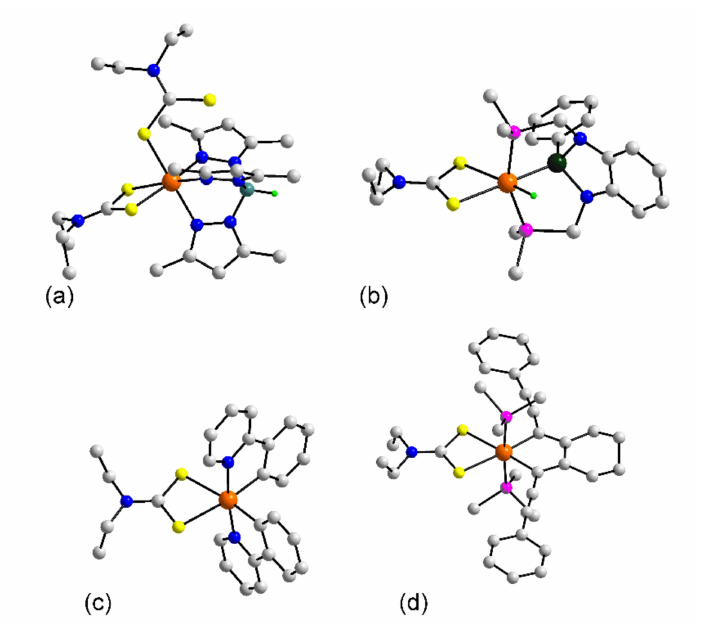
Figure 7. Molecular structures of rhodium complexes: ( a ) Tp*Rh( η 2 - L 24 )( η 1 - L 24 ) ( 73 ), ( b ) [Rh(H){ κ 3 - P,Si,P (cid:48) -SiPh(NCH 2 PPh 2 ) 2 C 6 H 4 }( L 24 )] in the crystal of 74 , ( c ) Rh(phpy) 2 ( L 24 ) ( 75 ), and ( d ) (PMe 3 ) 2 Rh(X 2 ) ( L 24 ) ( 77 ). In ( b ), only the ispo-C atoms of the phosphane bound phenyl rings are shown for